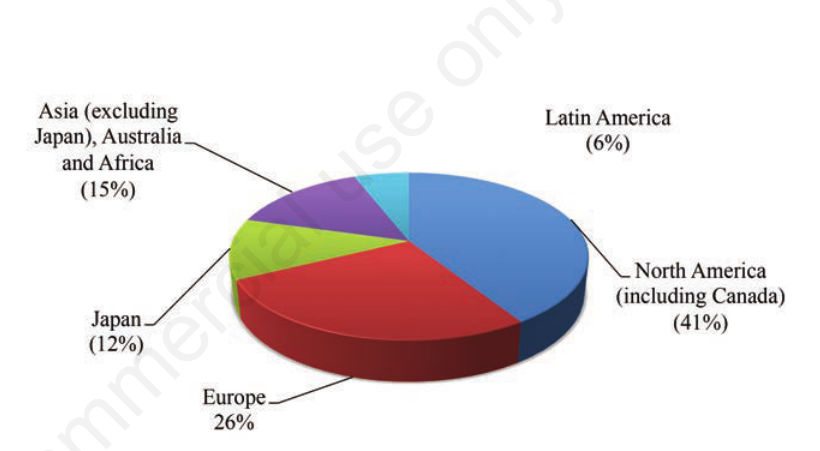
Figure 1. Status of global pharmaceuticals production continent wise.